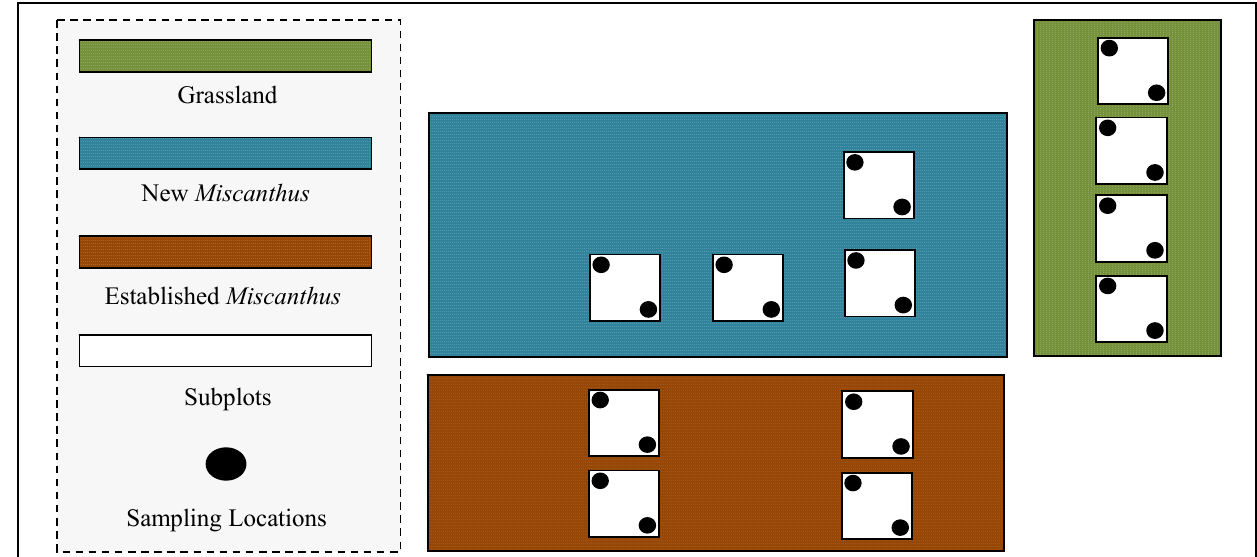
Figure 1. Diagram of experimental layout (not to